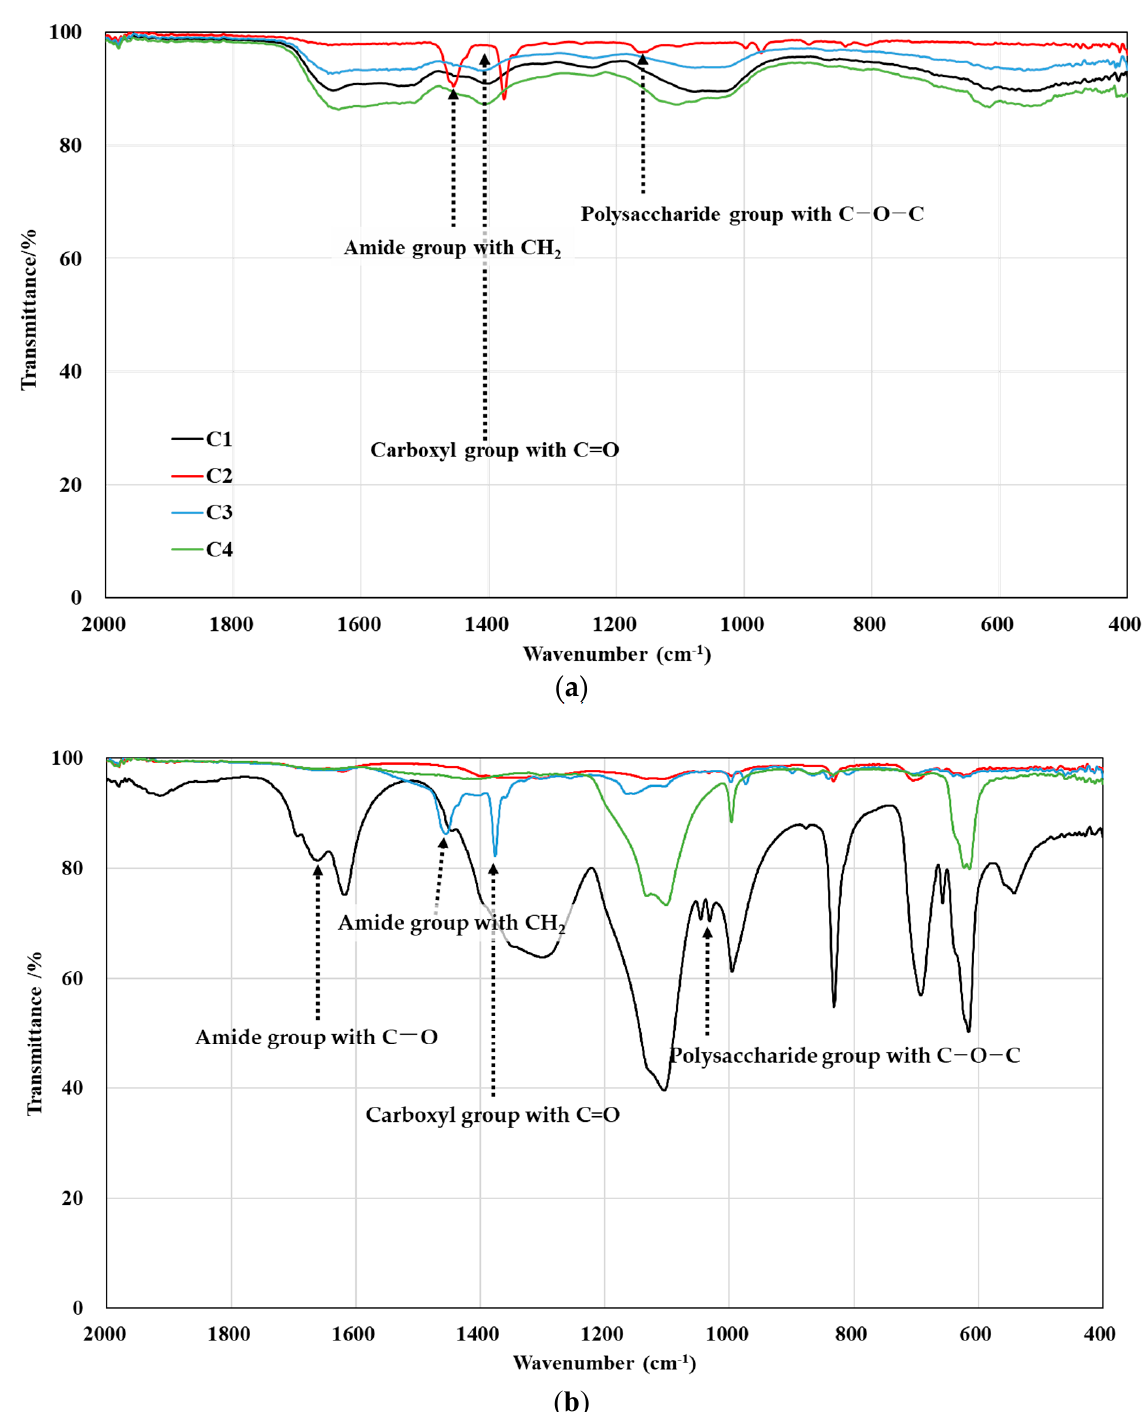
Figure 5. FTIR spectra of bound EPS ( a ) and soluble EPS ( b ) at C1 (no salt and no cation), C2 (5 g NaCl/L and no cation), C3 (5 g NaCl/L and 200 mg/L Ca 2+ ), and C4 (5 g NaCl/L and 70 mg/L Mg 2+ ).